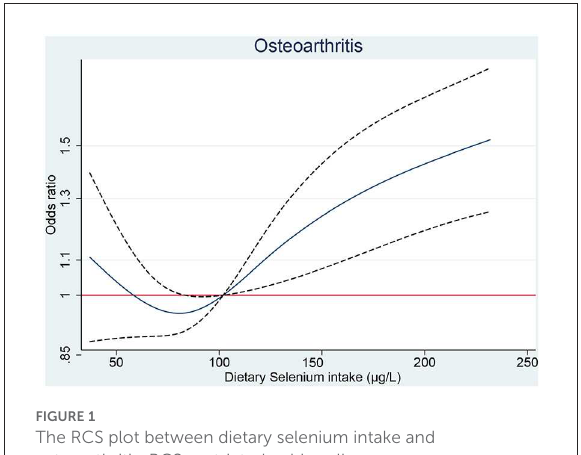
FIGURE1 The RCS plot between dietary selenium intake and osteoarthritis. RCS, restricted cubic